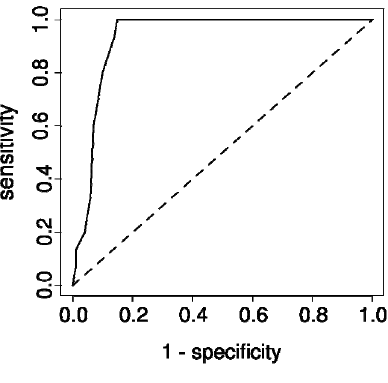
Figure 2. Receiver operating characteristic (ROC) curve of let-7c from our miRNA array dataset. For ROC curves of other miRNAs, see Figure